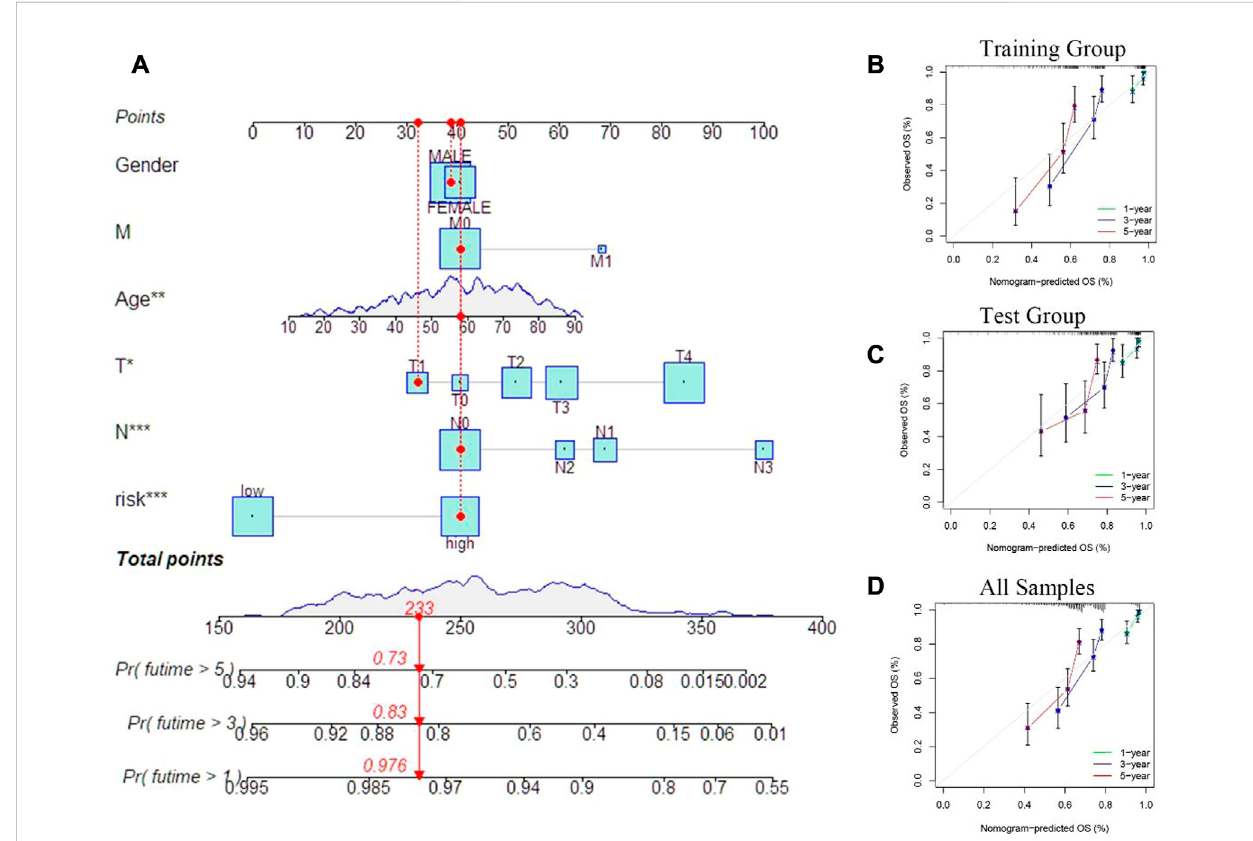
FIGURE 8 Prognostic model evaluation. (A) Nomogram with risk score and clinical characteristics of melanoma patients. (B – D) Calibration curves show the difference between the 1 -, 3 -, and 5-year operating systems predicted by the training and test groups (including all samples) and the actual operating